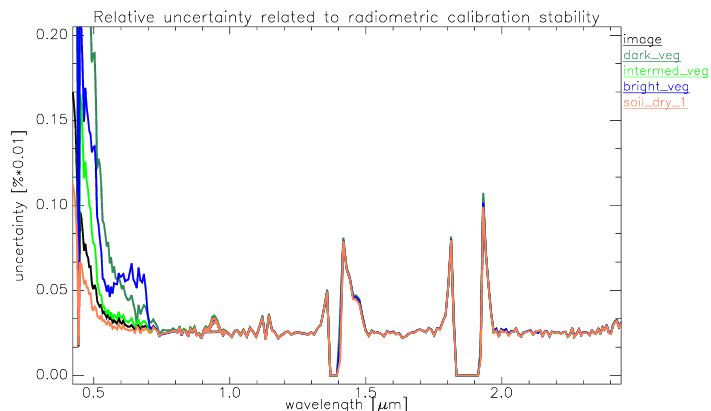
Figure 7. Plot of the relative standard deviation (stdev) for all ROI classes, representing the relative combined standard